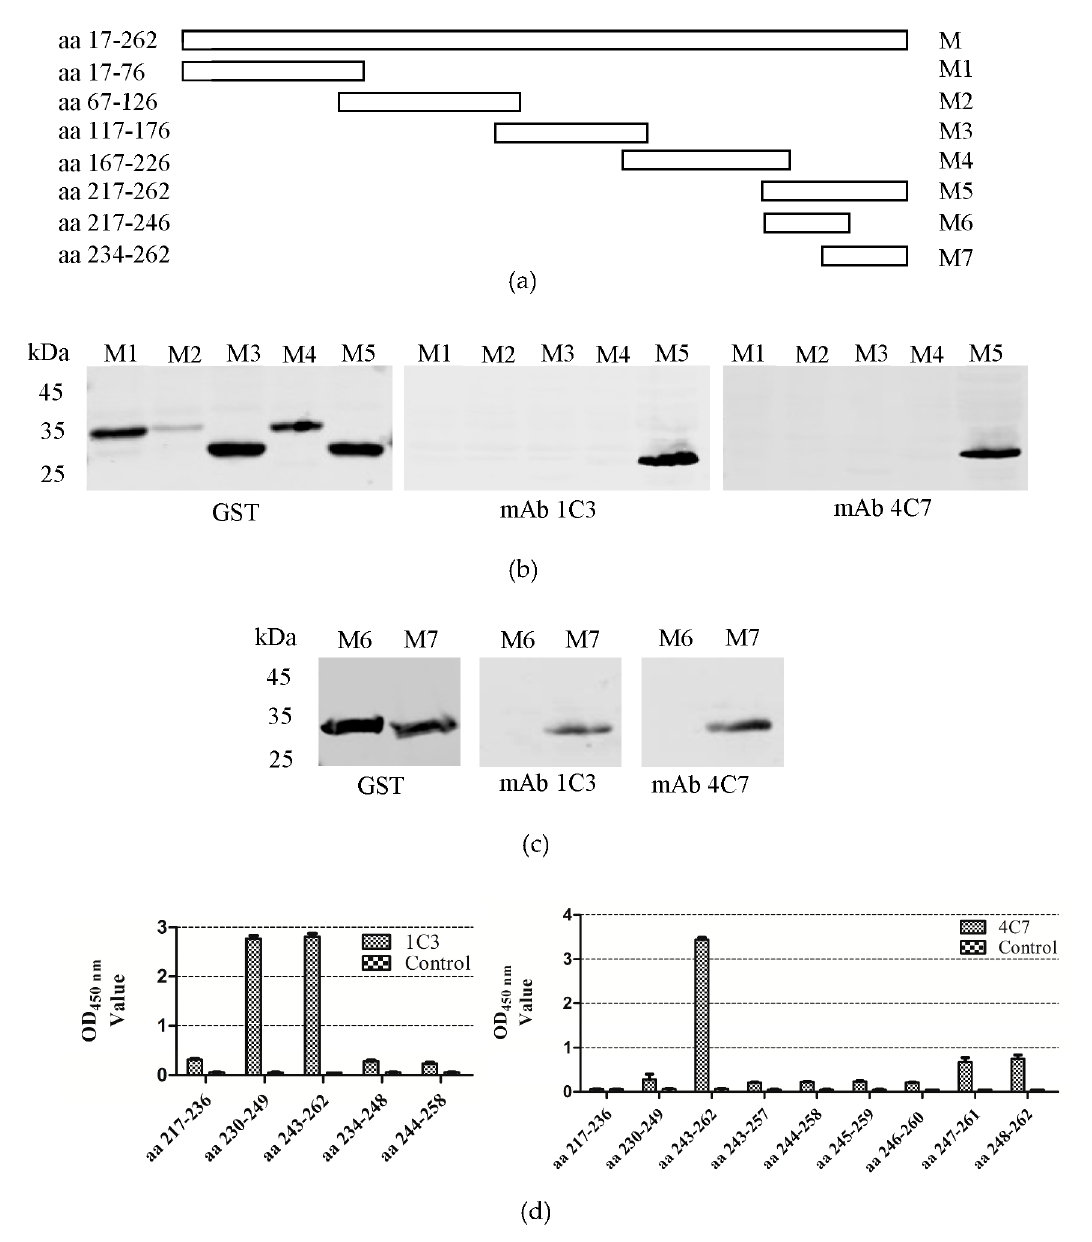
Figure 2. Identification of the epitopes of the 1C3 and 4C7 mAbs. ( a ) Scheme of the M protein and M fragments; ( b ) Western blotting analysis of the GST-M1, GST-M2, GST-M3, GST-M4, and GST-M5 proteins using the 1C3 and 4C7 mAbs; ( c ) Western blotting analysis of the GST-M6 and GST-M7 proteins using the 1C3 and 4C7 mAbs; ( d ) Five peptides were reacted with the mAb 1C3 and nine peptides with 4C7 by peptide ELISA. aa represents amino acids. PM represents protein